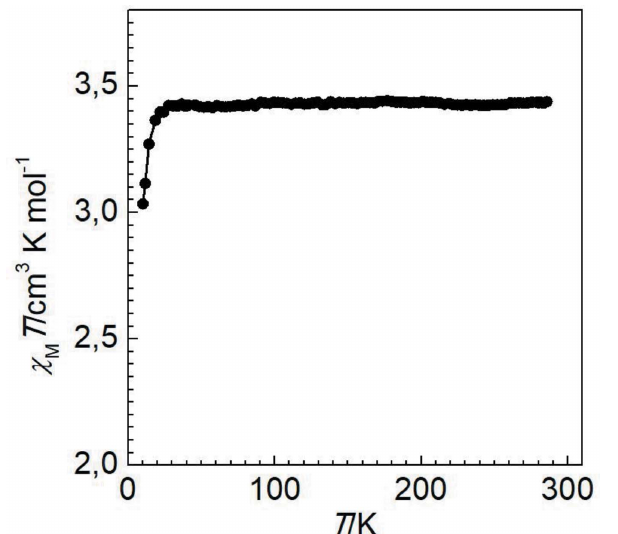
Figure 5 (cid:3) M T versus T plot for the title